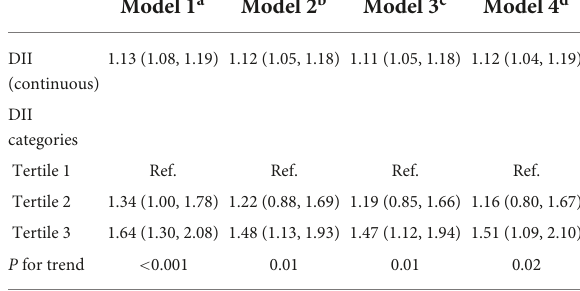
TABLE 2 Association between DII and